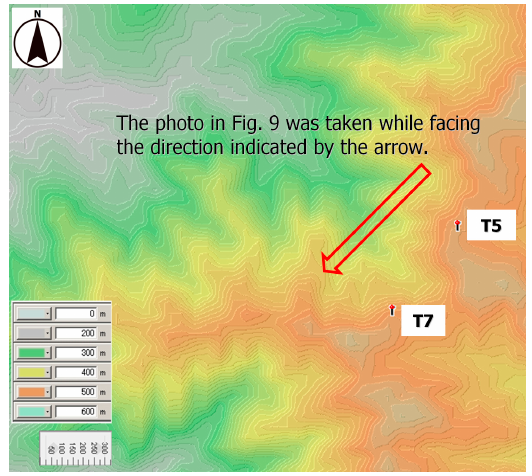
Figure 8. Topography in the vicinity of T7.